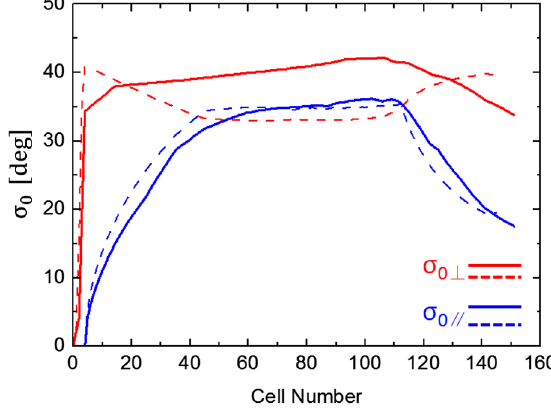
FIG. 2. The evolution of the phase advance at zero